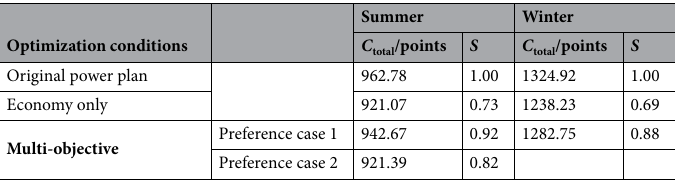
Table 7. Optimization results in different